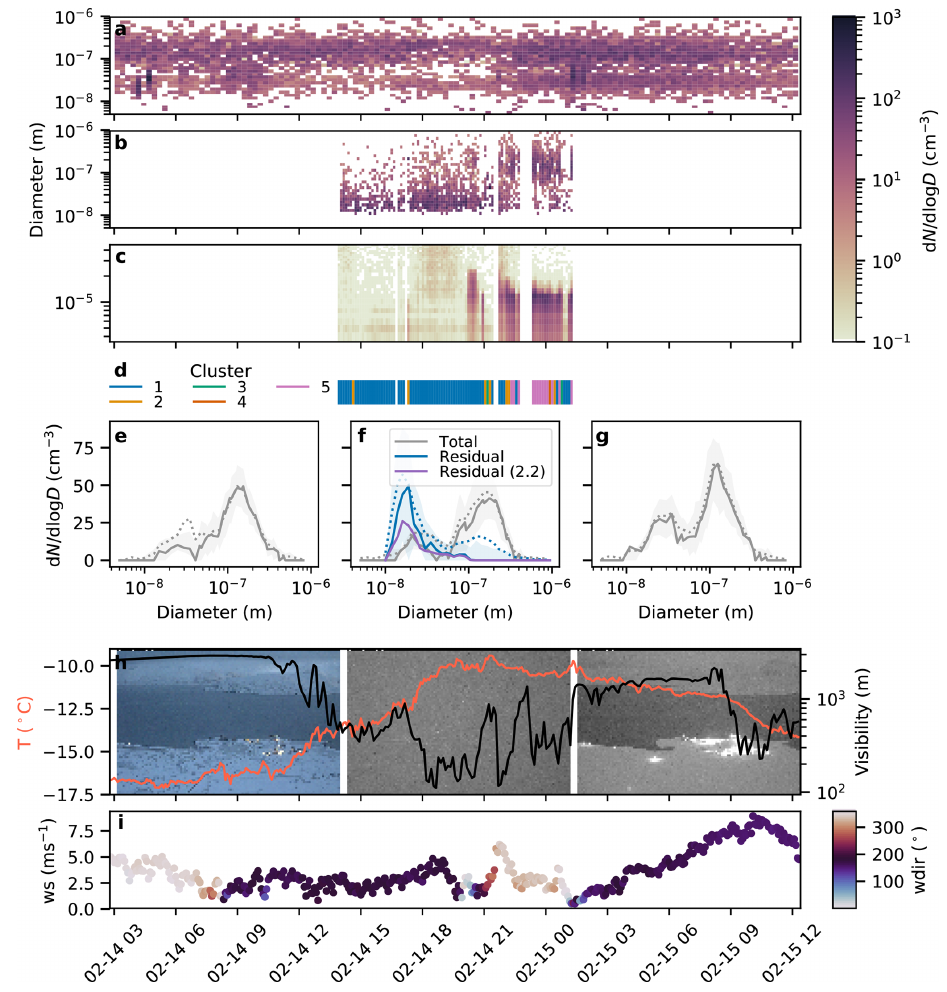
Figure A3. Case study II: cluster 1 cloud event on 14 February 2017. The first three panels show (a) total, (b) cloud residual, and (c) cloud particle number size distributions and their evolution over time. Panel (d) shows the cluster classification during the cloud event. Panels (e–g) show the average total particle size distributions (e) before, (f) during, and (g) after the cloud event. Solid and dotted lines show median and mean values, respectively, and shaded areas indicate the 25th to 75th percentile ranges. Panel (f) also includes the cloud residual size distribution data in colour (blue). The median cloud residual size distribution if one would use an average correction factor instead of individual correction factors is shown in purple for comparison. Panel (h) shows temperature (red, left) and visibility (black, right) over time, with background images of one webcam photo from Zeppelin Observatory (Pedersen, 2013) for each of the three periods. Panel (i) shows wind speed colour coded by wind